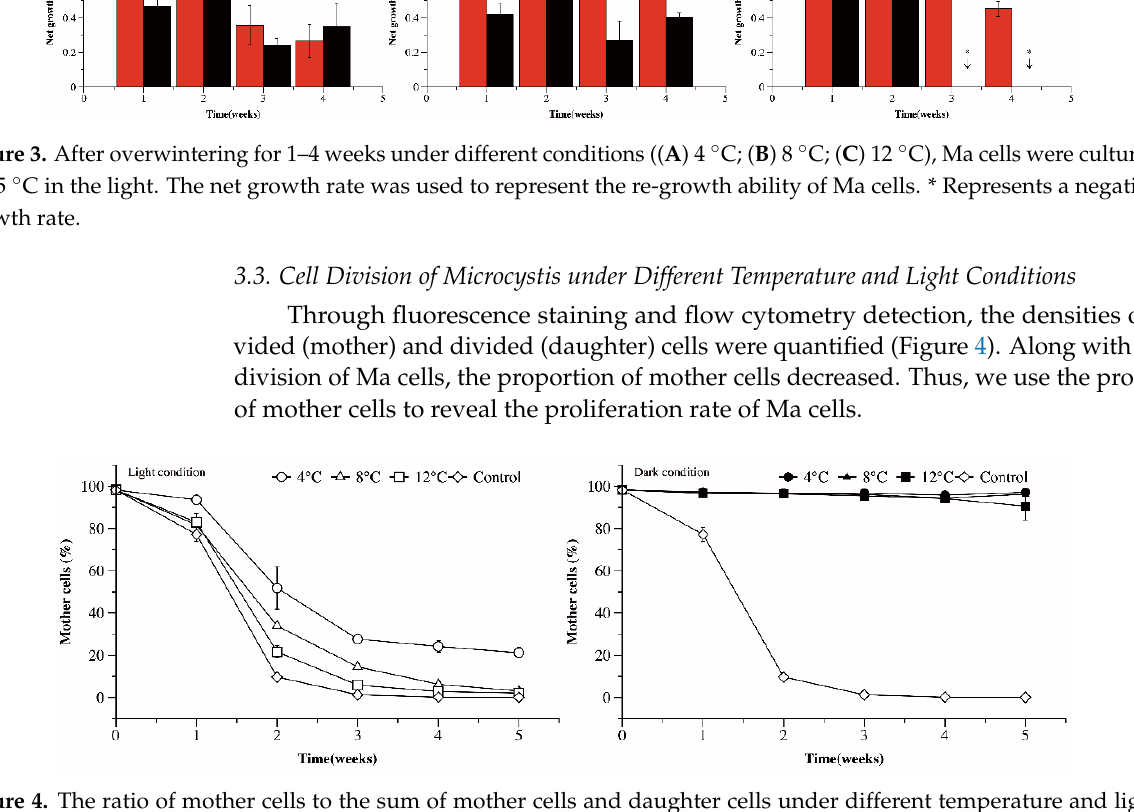
Figure 5. The ratio of undamaged cells to the sum of damaged and undamaged cells at different temperature and light conditions. 3.5. Cell size and Complexity of Microcystis Cultured under Different Temperature and Light Conditions Forward scatter is correlated with the size or volume of a cell or particle. As a unicel- lular organism, the life cycle of Ma is the same as the cell cycle, which includes three phases: (1) the growth of mother cells, (2) cell division, and (3) the liberation of daughter cells. To maintain cell size, cell volume usually increases during the division process. A down and up trend in the values of forward scatter of Ma cells was observed in both con- trol cultures and those exposed to light conditions, corresponding with the liberation of daughter cells and growth of mother cells in the cell cycle (Figure 6). A significantly higher value of forward scatter in control cultures indicated that more cells were dividing than in cultures exposed to low temperatures. When exposed to darkness, the forward scatter